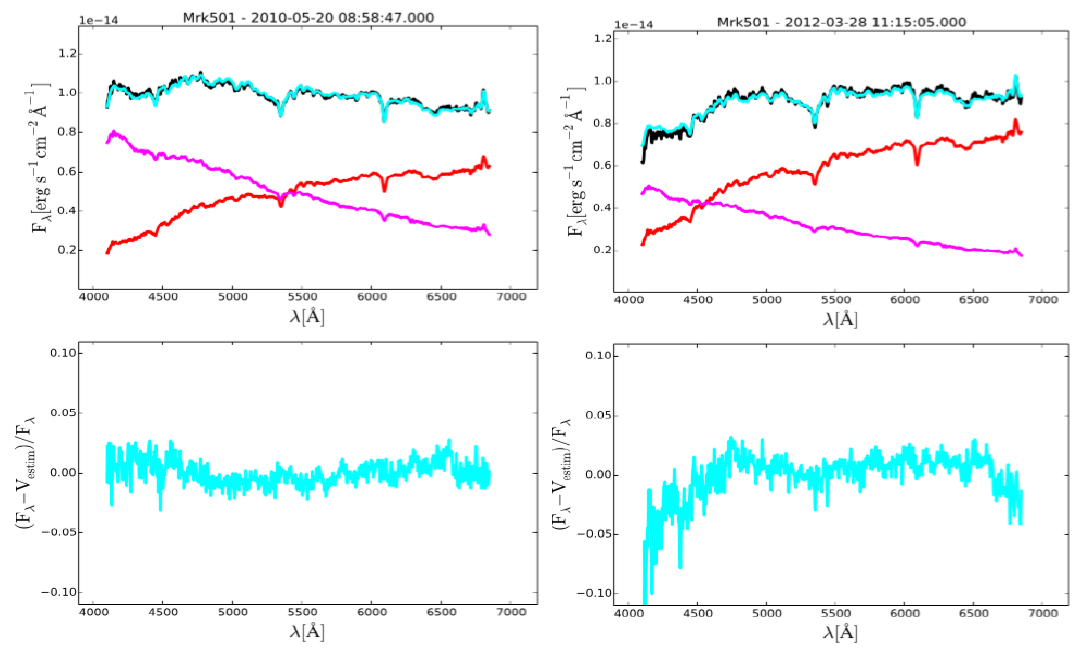
Figure 8. NMF decomposition of Mrk 501 spectra. Same representation as in Figure